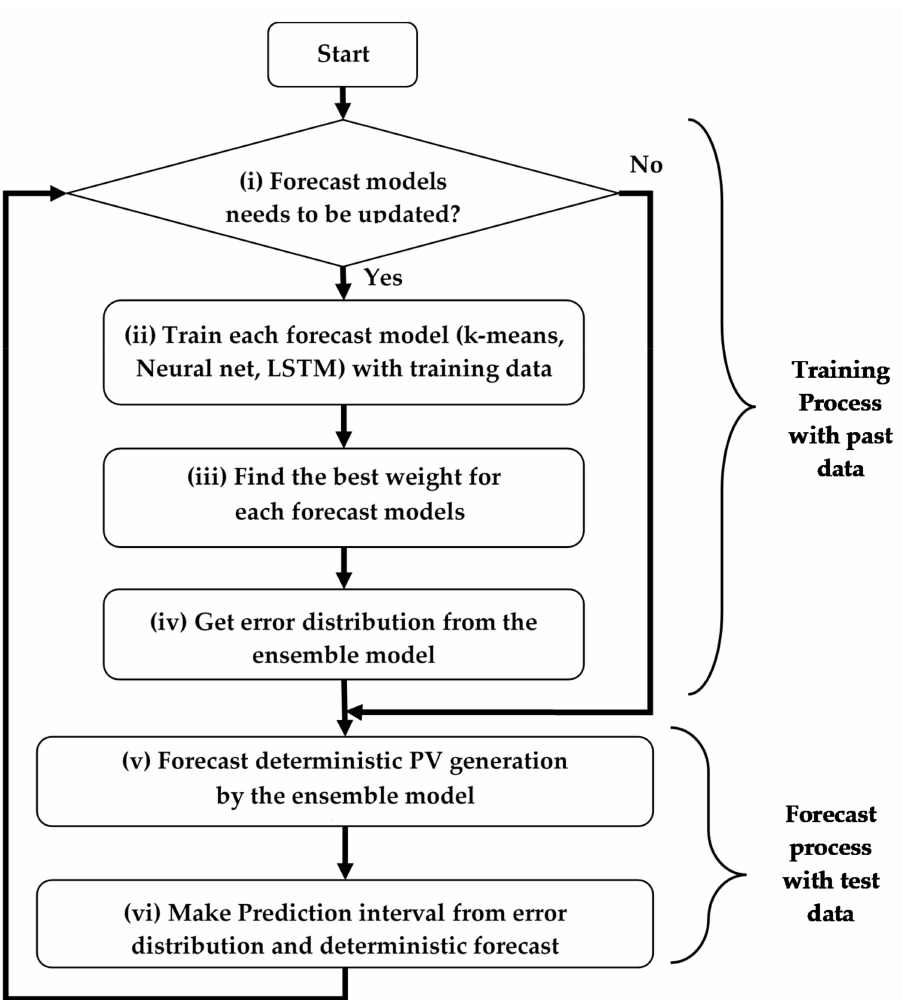
Figure 3. Configuration of an ensemble forecasting model.